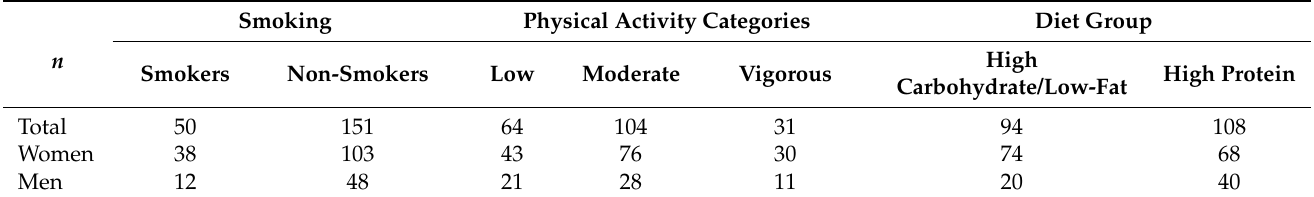
Table 1. Characteristics of the iMPROVE cohort by sex.